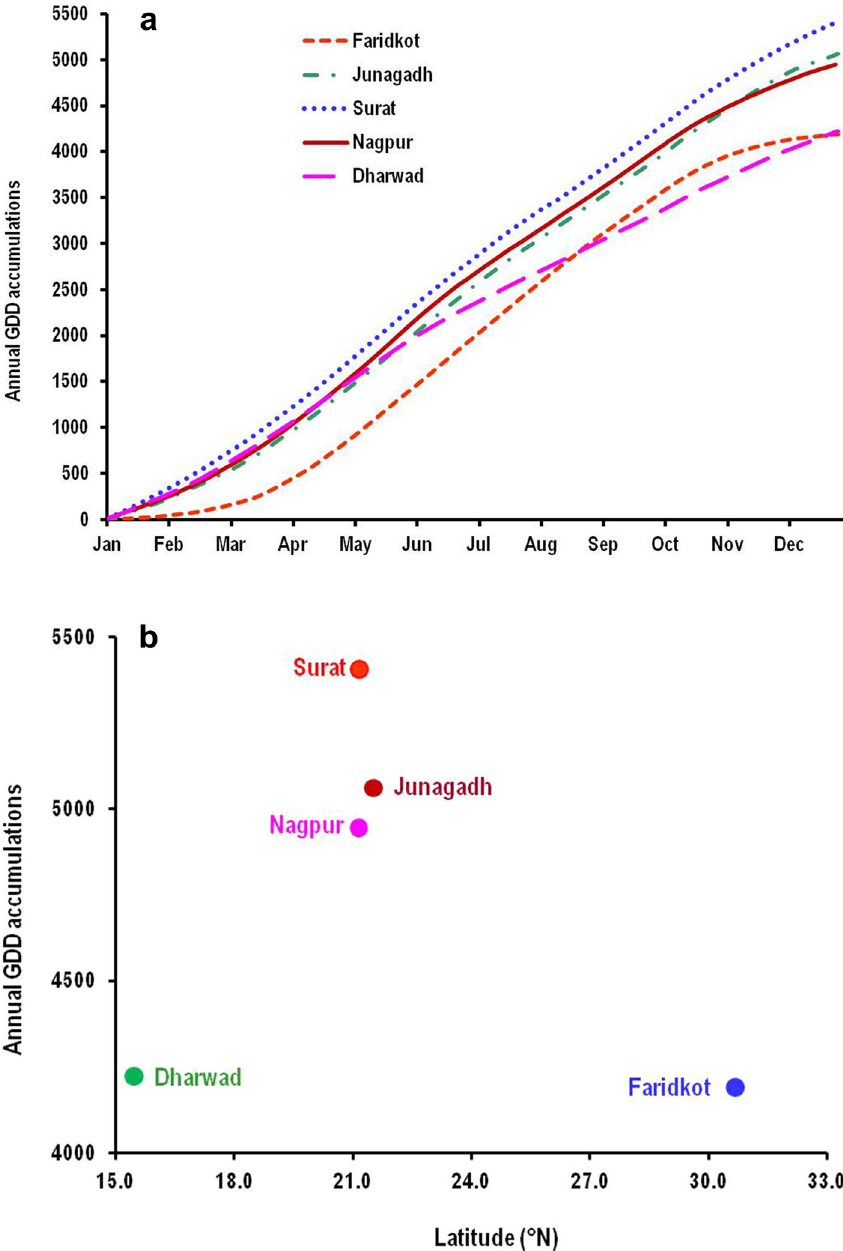
Figure 6. Mean annual growing degree days (GDD) accumulated at each sampling sites averaged over all the study years ( a ) and latitudinal variation in mean GDD accumulation for different sampling sites ordered by latitude from south to north ( b